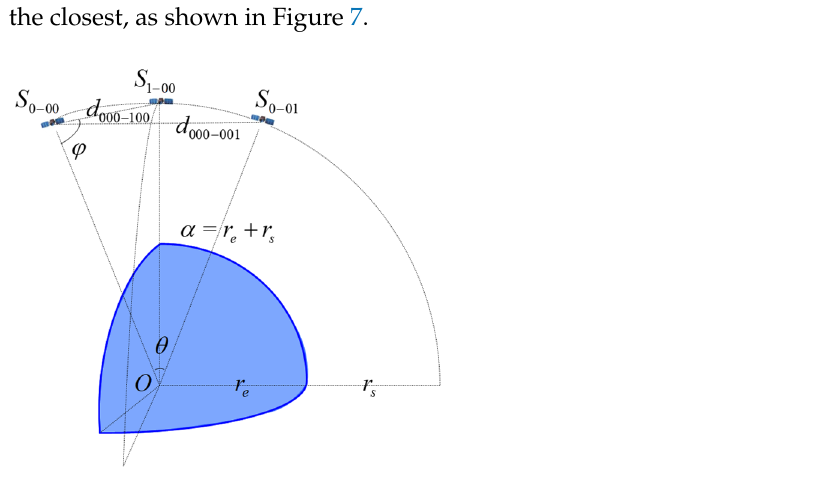
Figure 7. ISL with the closest communication distance between adjacent orbital planes.